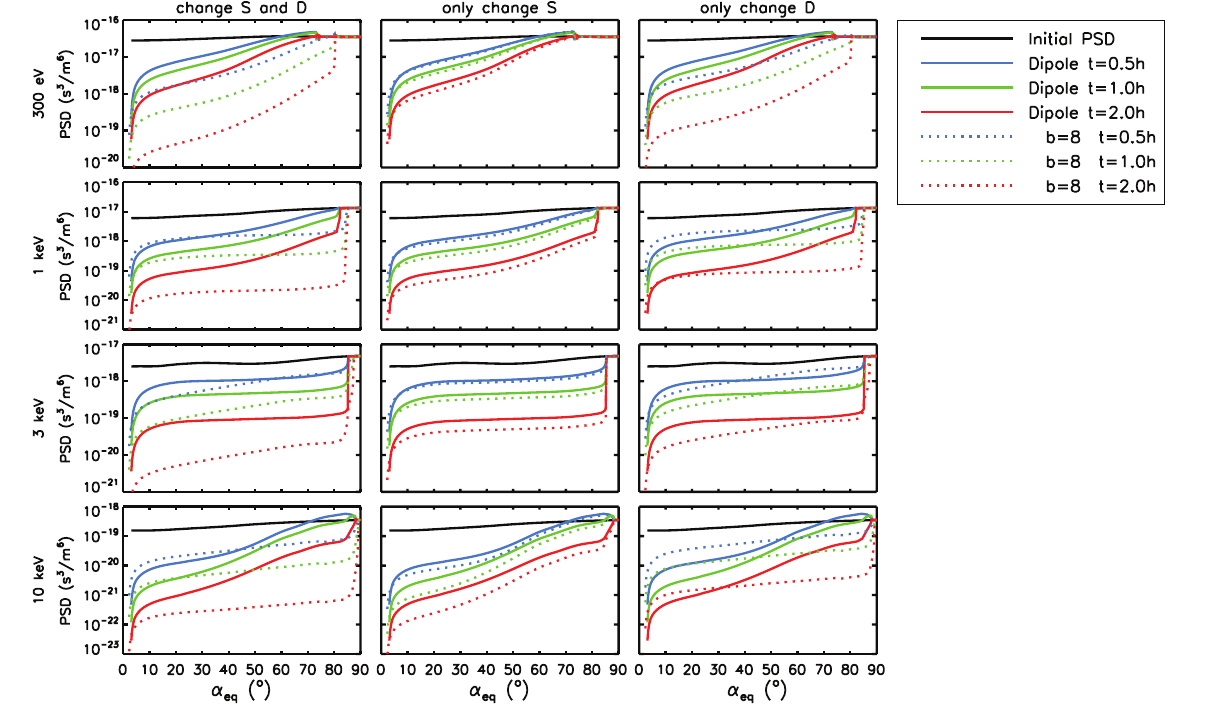
Fig. 6. Comparison of the effects of bounce period related term S(α eq ) and bounce-averaged diffusion coefficients ( D ) on electron PSD (s 3 m − 6 ) evolution by using different magnetic field models: dipole (solid) and the Dungey model b = 8 (dotted). Results are given for four specified energies of 300eV, 1keV, 3keV and 10keV after four time scales of PSD evolution: t = 0 . 0h (black), t = 0 . 5h (blue), t = 1 . 0h (green) and t = 2 . 0h